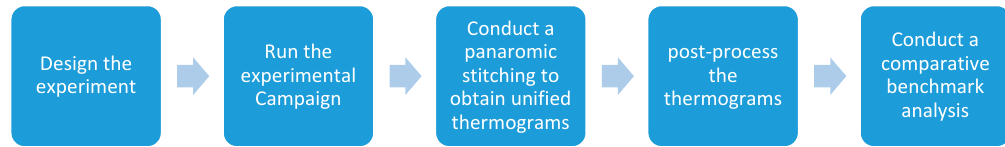
Figure 1. Methodology flow chart.